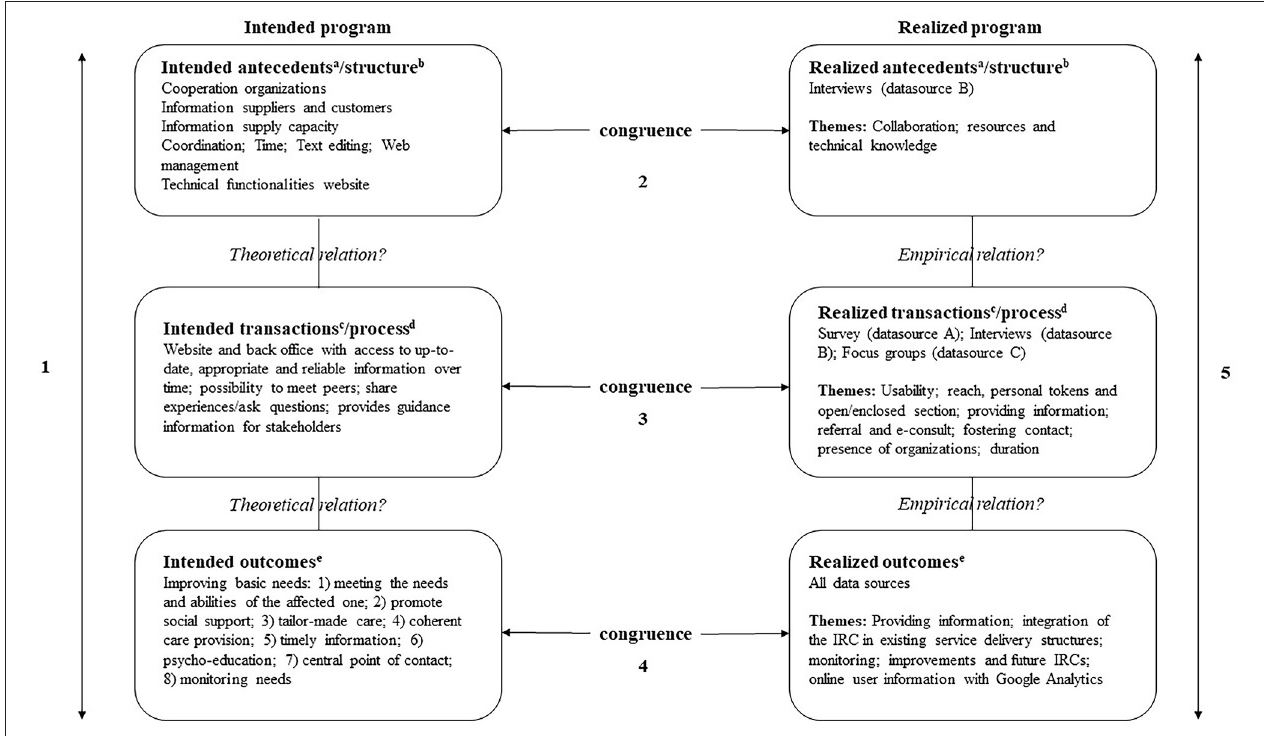
FIGURE 1 | Evaluation framework of Stake (44, 45) and Donabedian model of quality (1988) applied to the IRC evaluation. a Antecedents are various background conditions and inputs ( 45); b Structure refers to the context and conditions (46); c Transactions are program activities, operations, functions and processes (45); d Process refers to transactions between care recipients and providers ( 46); e Outcomes refer to the accomplishments or actual outcomes of the program (45,